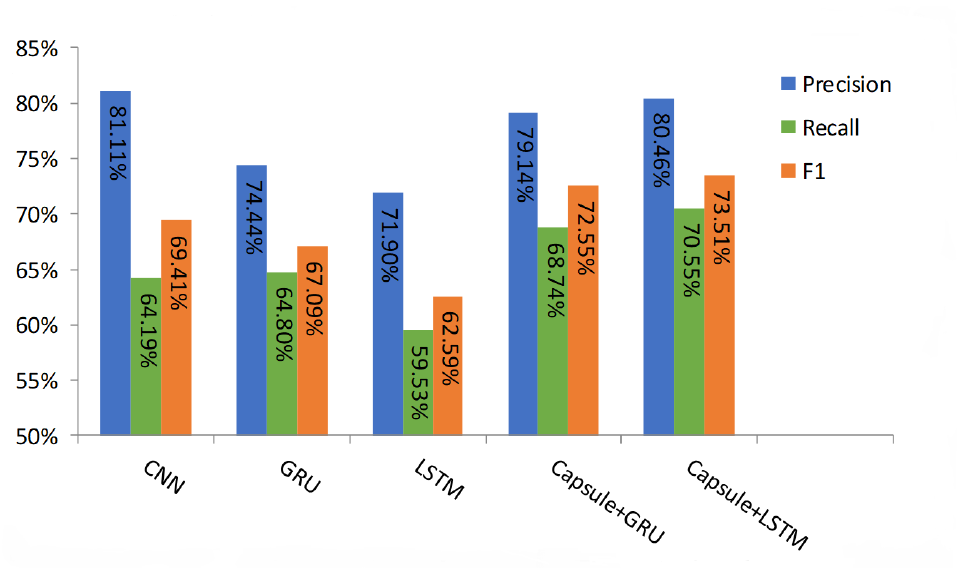
Figure 3. Comparison of improved Capsule networks with different baseline